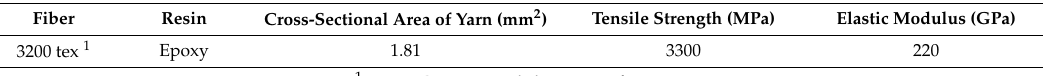
Table 1. Material properties of textile grid in warp direction (suggested by the manufacturer). Fiber